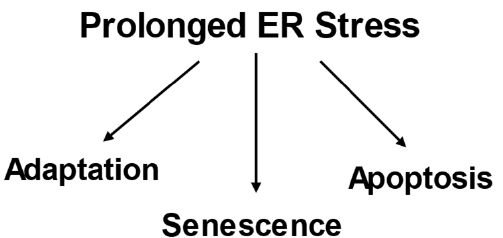
Figure 2. Cellular Responses to Prolonged Levels of ER Stress.